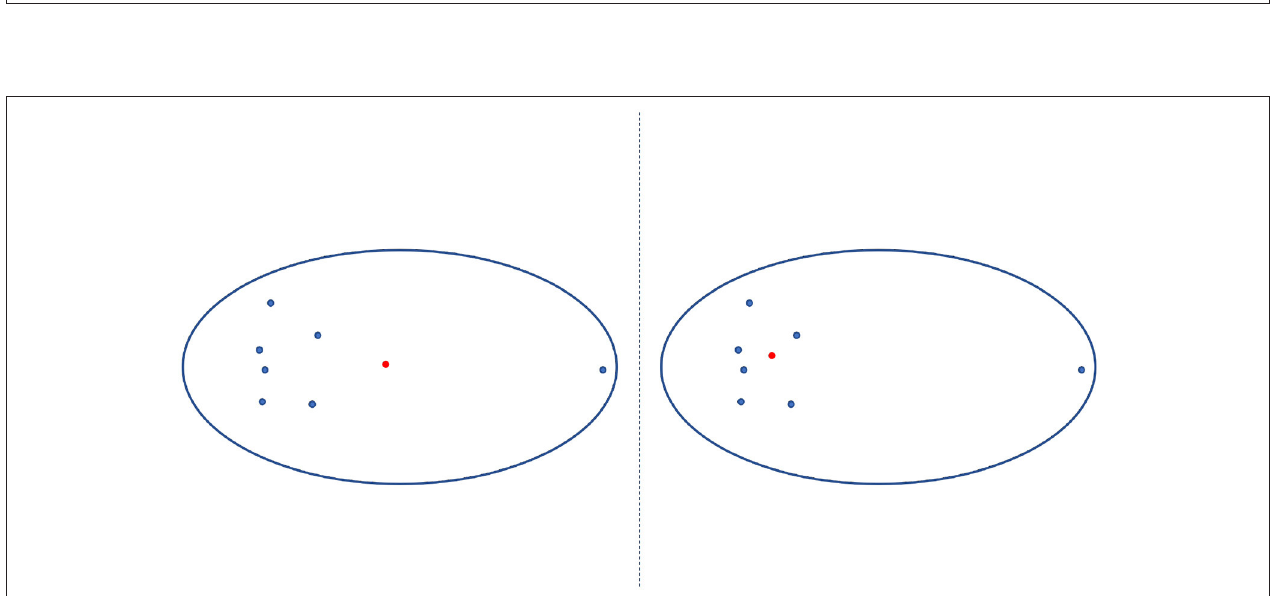
FIGURE 6 | Mean center vs. medoid center. The mean center is indicated by the red dot in the left panel and differs the medoid center (indicated by the red dot in the right panel), which is the most central object in the clusters with the smallest sum of distances from other data.